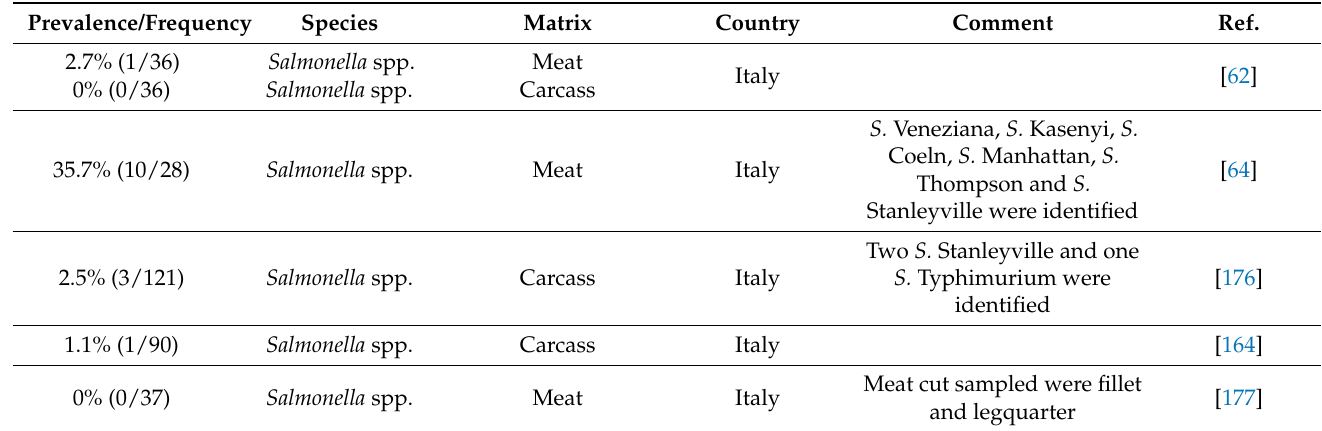
Table 10. Prevalence of Salmonella spp. in wild boar meat and carcasses,